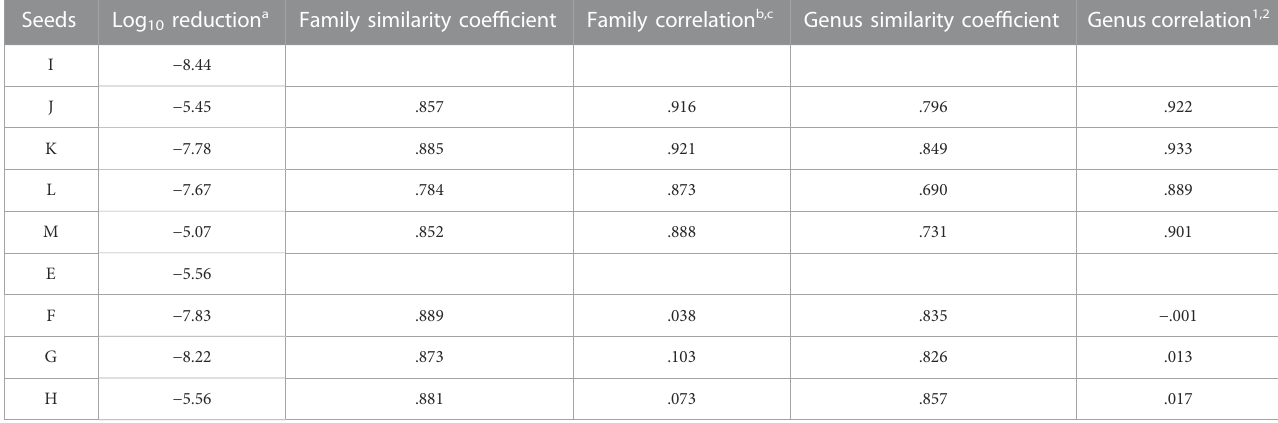
TABLE 4 Similarity in bacterial composition between seeds, exhibiting high (Seed I) or low (Seed E) Salmonella reduction, with their commercial lots. Seeds Log 10 reduction a Family similarity coef fi cient Family correlation b,c